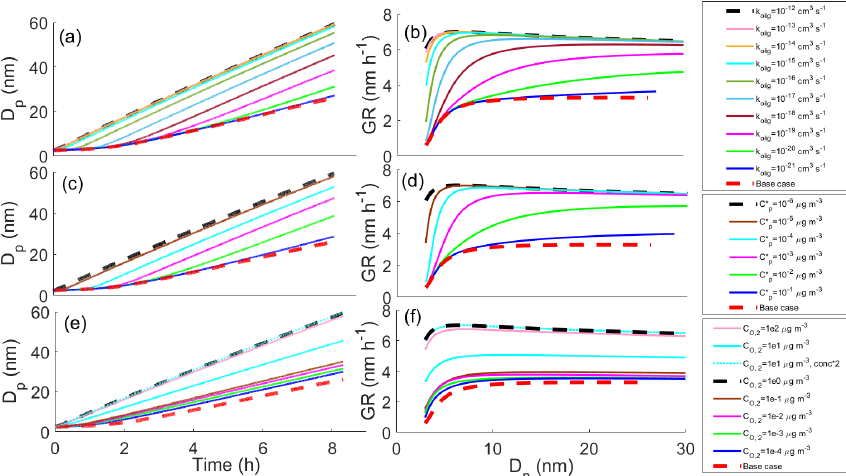
Figure 2. Diameter of the particle ( D p ) as a function of time and growth rate (GR) of the particle as a function of diameter in simulations in which two model compounds oligomerize forming a new oligomerization product, (a, b) for simulations with different oligomerization rate coefficients, (c, d) for simulations with different saturation concentrations of oligomerization product compounds ( C ∗ p ) and (e, f) for simulations with different saturation concentrations of one of the oligomerizing compounds ( C ∗ ). Except for the parameter that was O , 2 = 10 0 µgm − 3 and the saturation concentration of the varied, values were as follows: k olig = 10 − 12 cm 3 s − 1 , C ∗ p = 10 − 6 µgm − 3 , C ∗ O , 2 = 10 1 µgm − 3 . These parameter values correspond to the simulation with the fastest growth among the other reacting compound C ∗ O , 1 Case 1 simulations, which is present in every panel as a dashed black line. The base case simulation in each panel describes simulation without oligomerization reactions. Panels (e) – (f) also present simulation, in which both oligomerizing compounds are from same volatility bin ( C ∗ = 10 1 µgm − 3 ), and two-thirds of compounds in that volatility bin can go through oligomerization reaction. In other simulations one-third of a bin can go through a